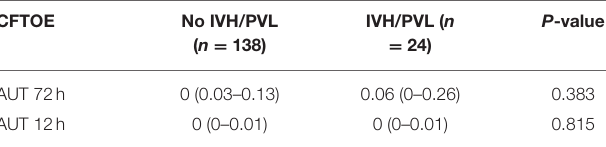
TABLE 6 | Area under the threshold for CFTOE in the first 12 and 72h of life. P -value CFTOE No IVH/PVL IVH/PVL ( n = 24) ( n = 138) AUT 72h 0.383